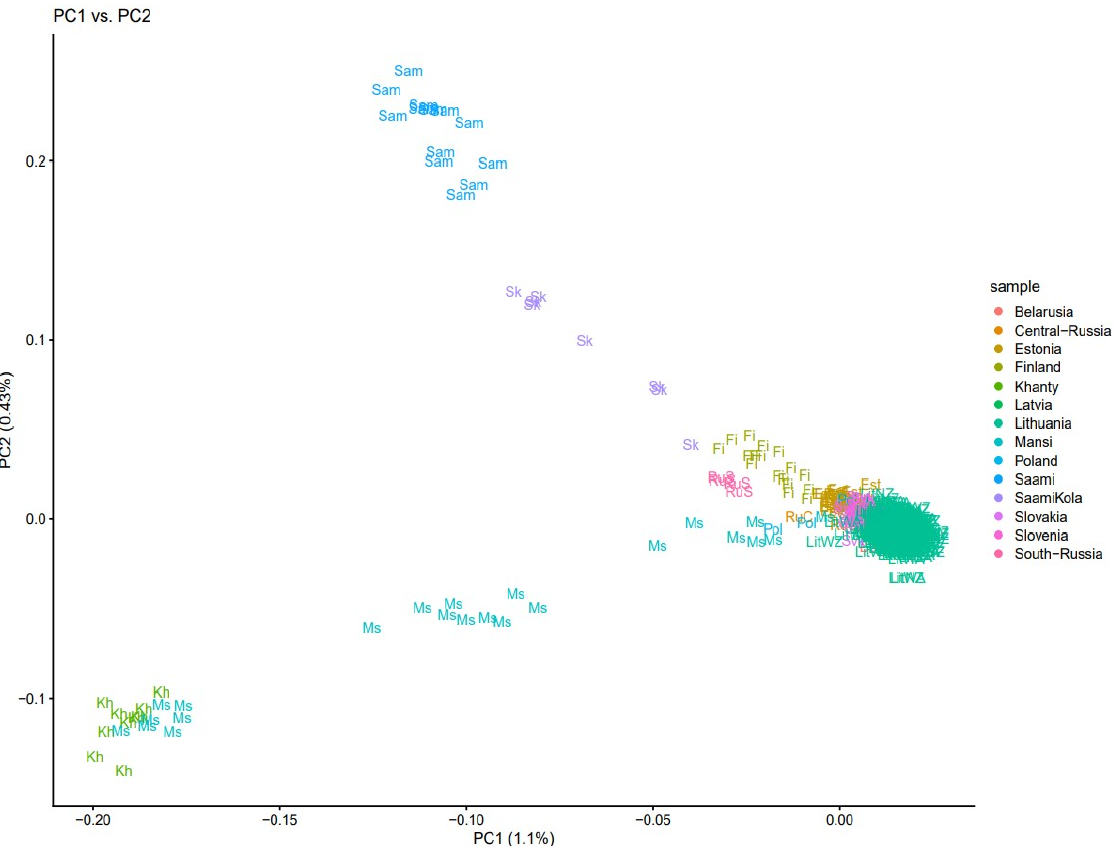
Figure 1. Principal component analysis of 105,853 SNPs in 579 individuals. The first principal component separates North-Eastern European, except the Finns, and Slavic populations from the rest.